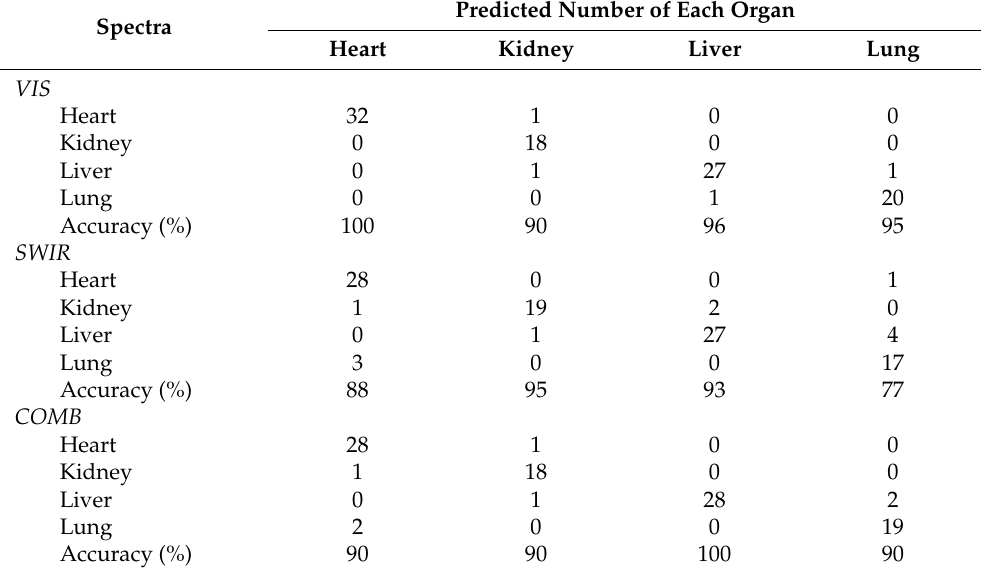
Table 3. Performance of visible (VIS), short-wave infrared (SWIR) and combination VIS and SWIR (COMB) hyperspectral sensors in identifying the type of organs using partial least squares discrimi- nant analysis on the in-sample